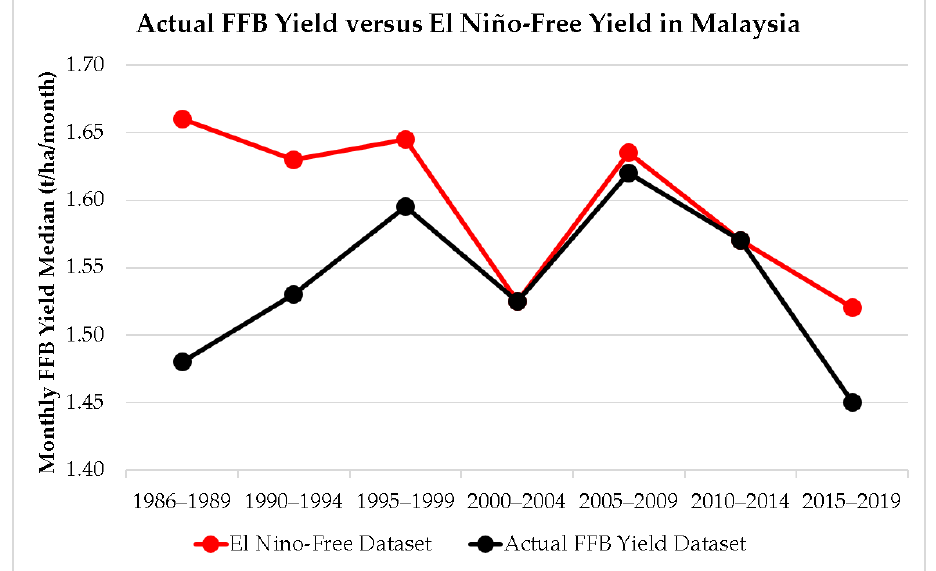
Figure 11. Comparison of monthly recorded FFB yield trend and El Niño – free yield data in Malaysia computed in median values for the aforementioned durations between 1986 and 2019. Actual FFB yield data recorded from January 1986 to December 2019 in Malaysia (N = 408 months), including 110 months of yield data, which are associated with El Niño as declared by [24 – 26], and 298 months of El Niño – free yield dataset.